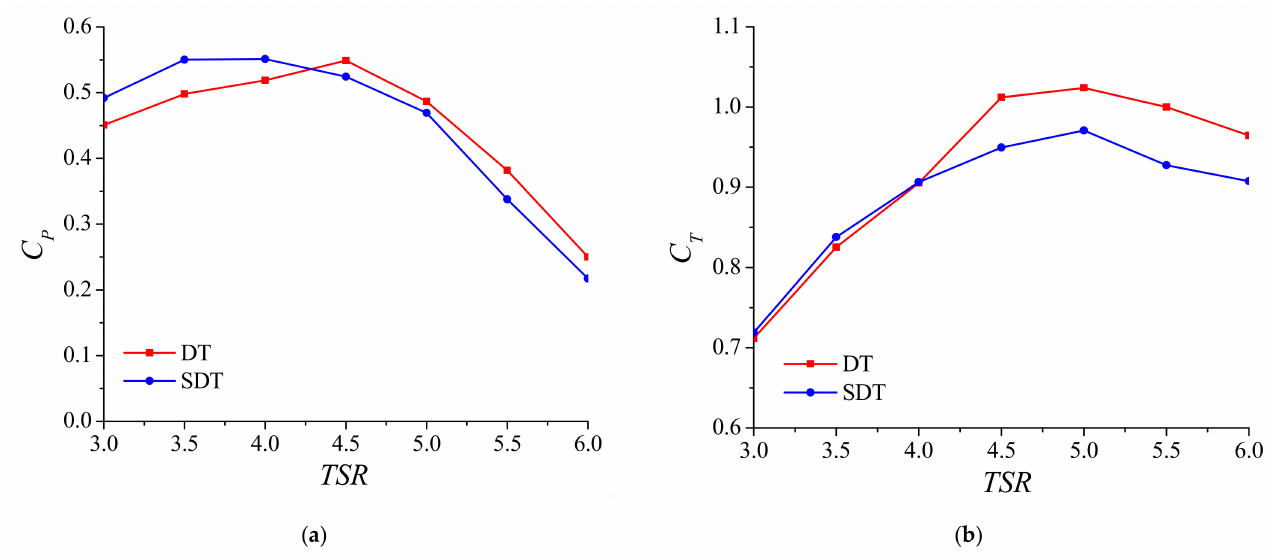
Figure 8. Hydrodynamic characteristic comparisons between the DT and the SDT: ( a ) power coefficient; ( b ) thrust